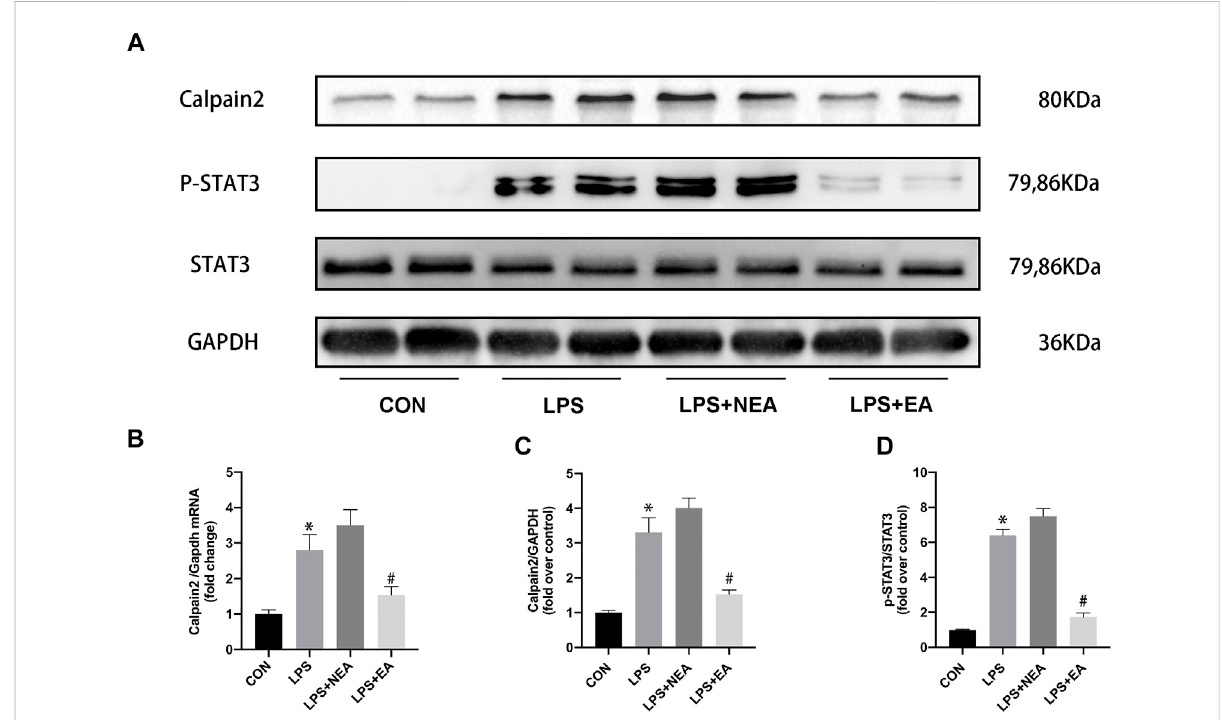
Effect of EA pre-treatment on the expression of calpain-2/STAT3. (A) Representative blot images of proteins related to calpain-2/p-STAT3. (B) mRNA expression of Calpain-2. (C – D) Quantitative analysisofcalpain-2 andp-STAT3 expression.N =4per group. EA,electroacupuncture;NEA, EA in non-acupoint; LPS, lipopolysaccharide. * p < 0.05 vs. control group, # p < 0.05 vs. LPS